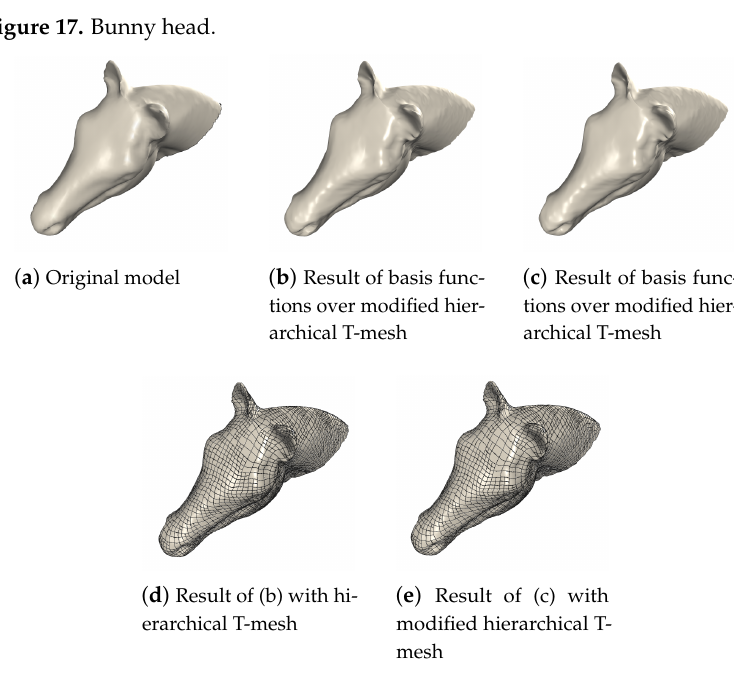
Figure 18. Horse